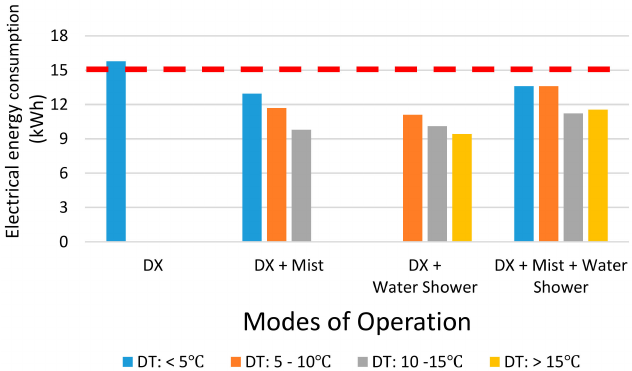
Figure 13. Electrical energy consumption of various modes of operation of the FAHU for di ff erent ranges of ∆ T HX in ambient temperatures higher than 40 ◦